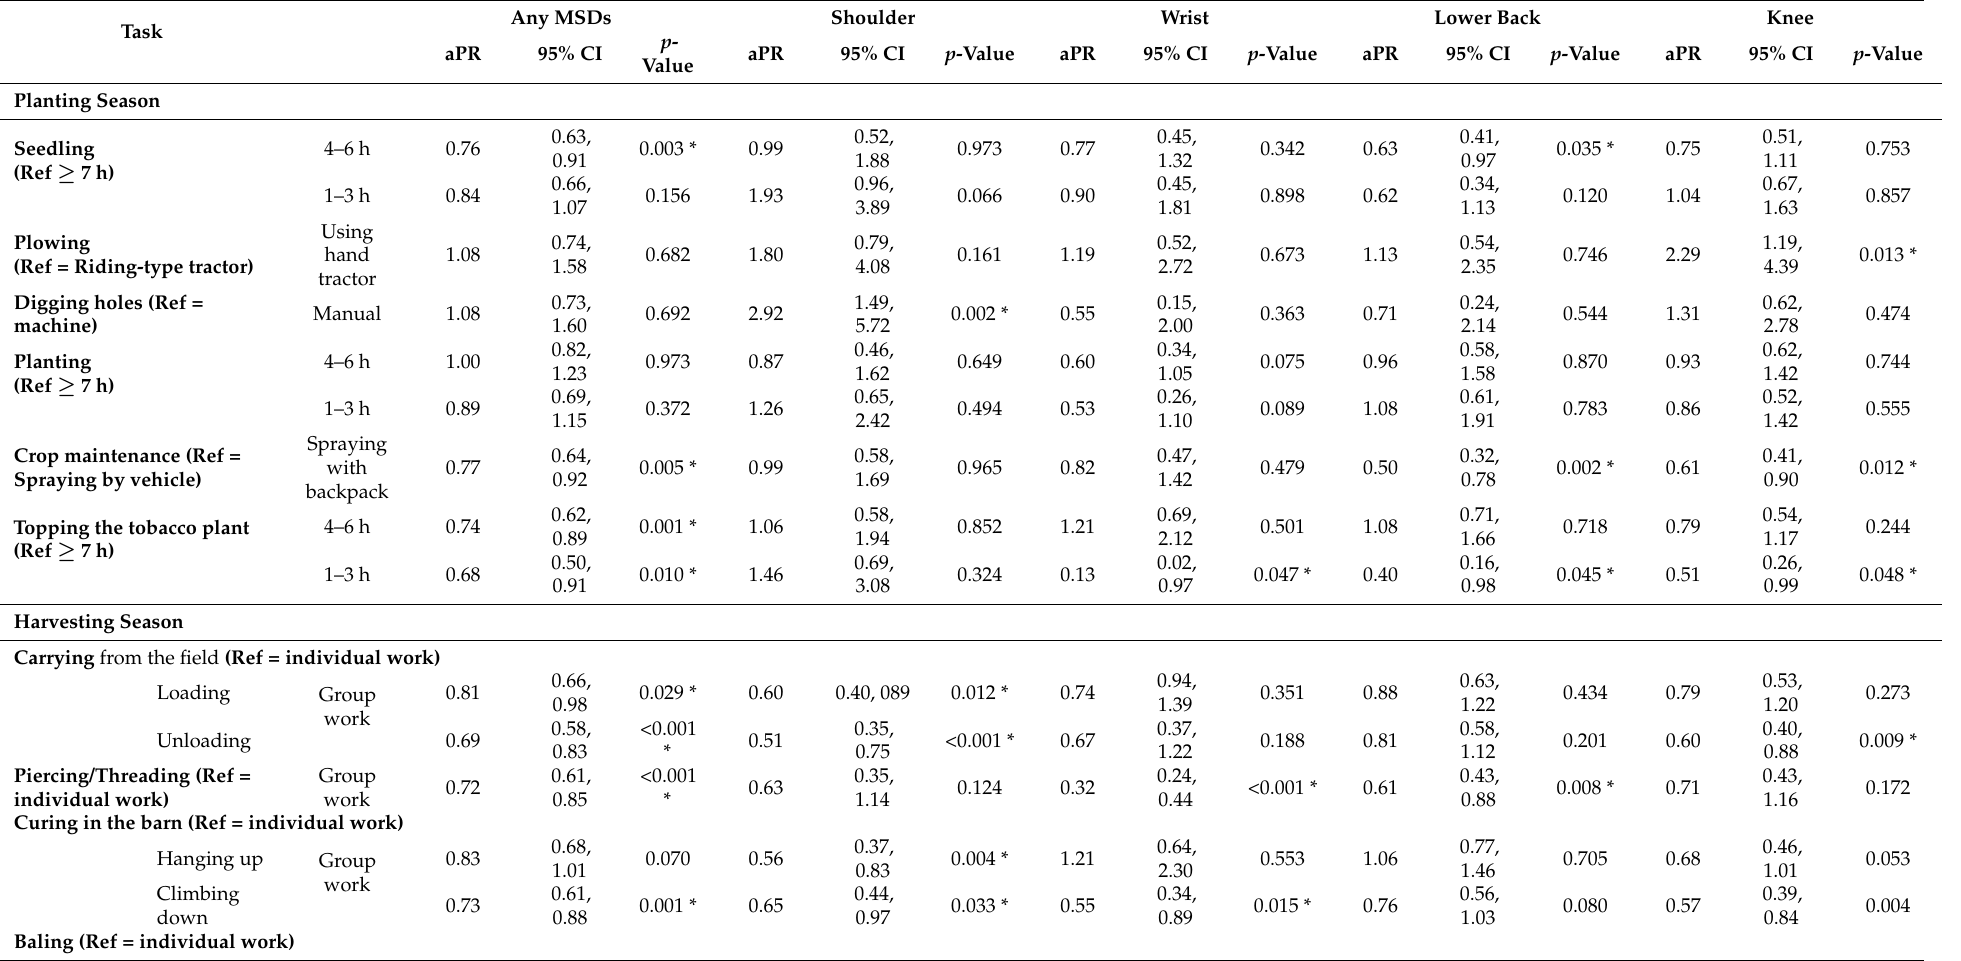
Table 4. Factors related to MSDs in the planting and harvesting seasons using Robust Poisson Regression adjusted by age, gender, and